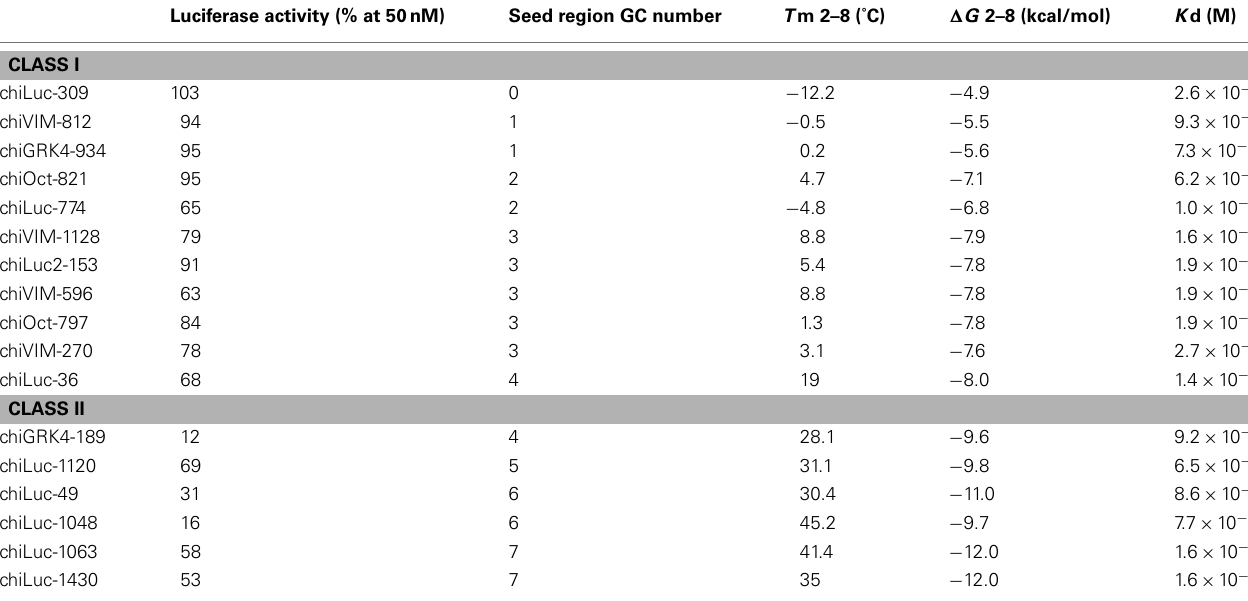
Table 3 | Relative luciferase activities and T ms, Δ G s, and K ds at seed regions of class I and II chiRNAs. Luciferase activity (% at